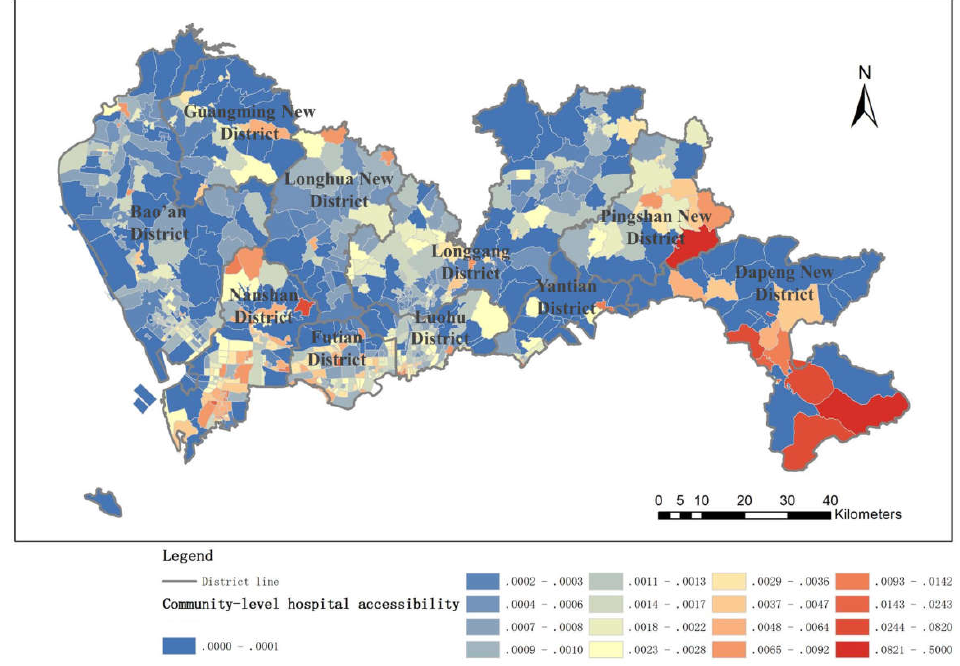
Figure 8. Community-level hospital Figure 8. Community‐level hospital accessibility.